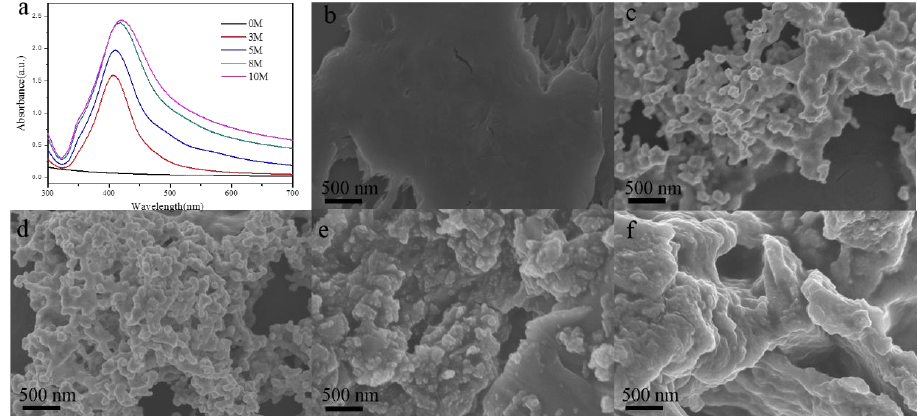
Figure 2. ( a ) UV-vis adsorption spectra of NCF (Black), NCF-Ag-3 mM (Bright red), NCF-Ag-5 mM (Blue), NCF-Ag-8 mM (Green), and NCF-Ag-10 mM (Plum purple); (SEM) images of ( b ) NCF, ( c )